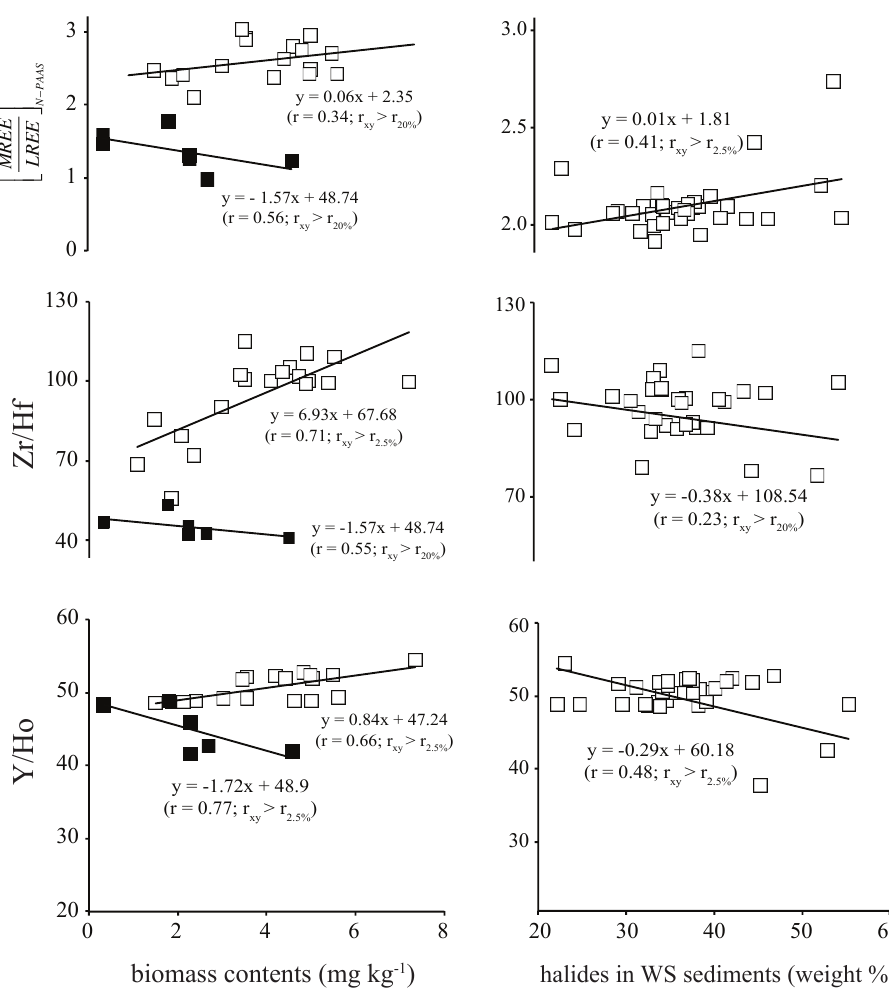
Fig. 6. Relationships between amplitudes of MREE enrichment (in terms of MREE/LREE normalised concentrations), Y/Ho and Zr/Hf molar ratios and biomass (mgkg − 1 ) and halide contents (weight %) in studied assemblages. Tests of significance for observed distributions have been carried out measuring the t a/ 2 Student factor. r xy > r nm% indicates that the measured sampling correlation factor r xy is greater than the appropriate t n − 2 degree of freedom. Symbols as in Fig. 4.